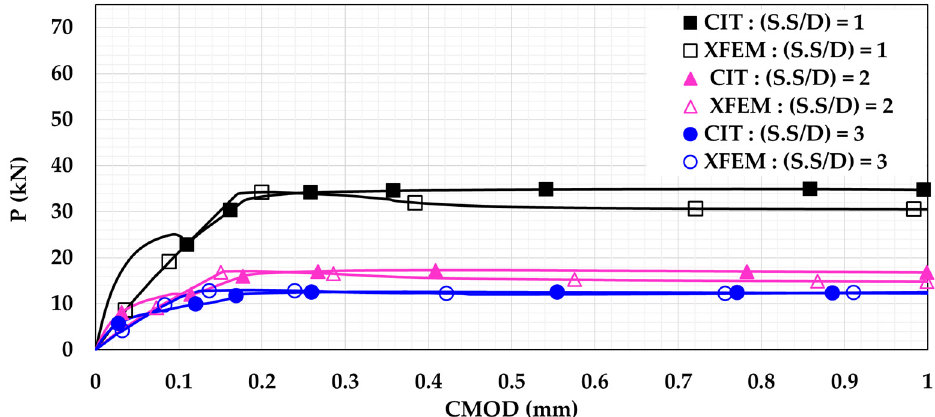
Figure 10. Reinforced concrete beam P-CMOD relationships for different shear span-to-depth ratios (S.S/D).